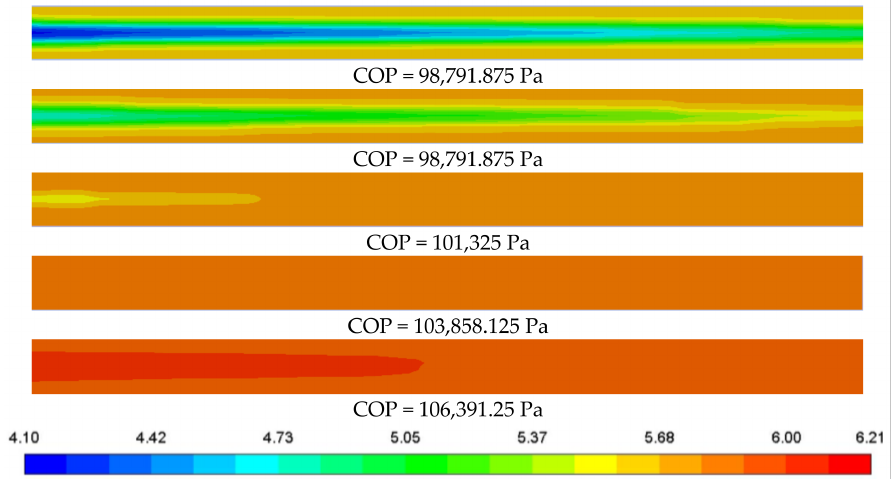
Figure 13. Water content distribution under the fluctuation of COP.